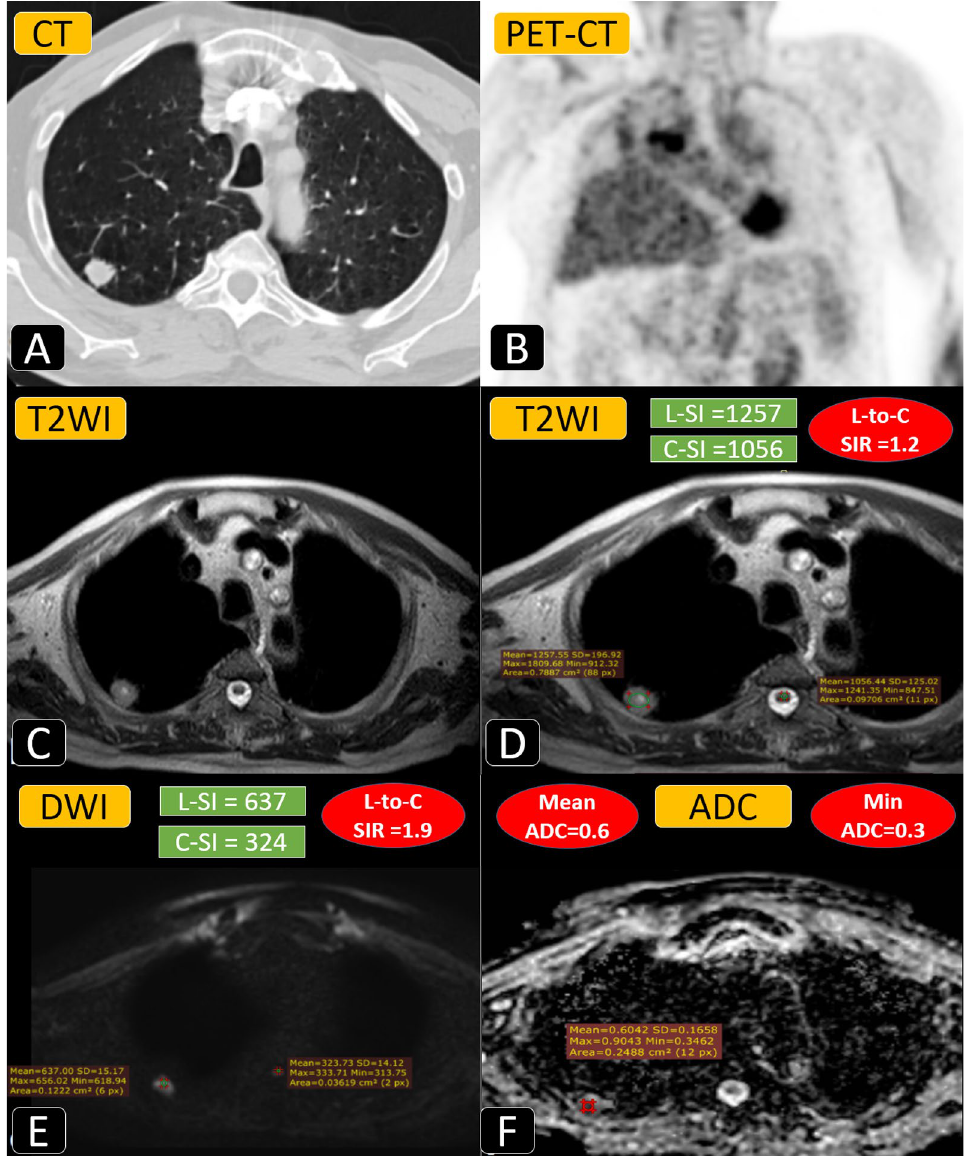
Fig. 6 A 67-year-old male patient with a history of primary hemangiopericytoma complained of chronic cough. A Axial chest CT cut (lung window) showed solitary right upper lobar posterior segmental sub-pleural solid homogeneous lung nodule showing minimum speculated outlines and faint pleural tag. B Coronal chest PET-CT image showing high 18F-FDG uptake at the right upper lobar nodular lesion. C, D Axial T2WI showing the iso-to-high signal intensity of the lesion. After placing two ROIs within the largest lesion and the spinal cord, the lesion-to-spinal cord signal intensity ratio was calculated 1.2. E Axial DWI showing bright signal of restricted diffusion and lesion-to-spinal cord signal intensity ratio was = calculated 1.9. F ADC mapping images showing low signal intensity with minimum ADC (0.3 10 − 3 mm 2 /s) and mean ADC (0.6 10 − 3 mm 2 /s). = × × Referring to the estimated cutoff values, T2WI L-to-SC SI ratio, DWI L-to-SC SI ratio, minimum ADC, and mean ADC suggested a malignant process. Pathologically proven solitary metastatic lung